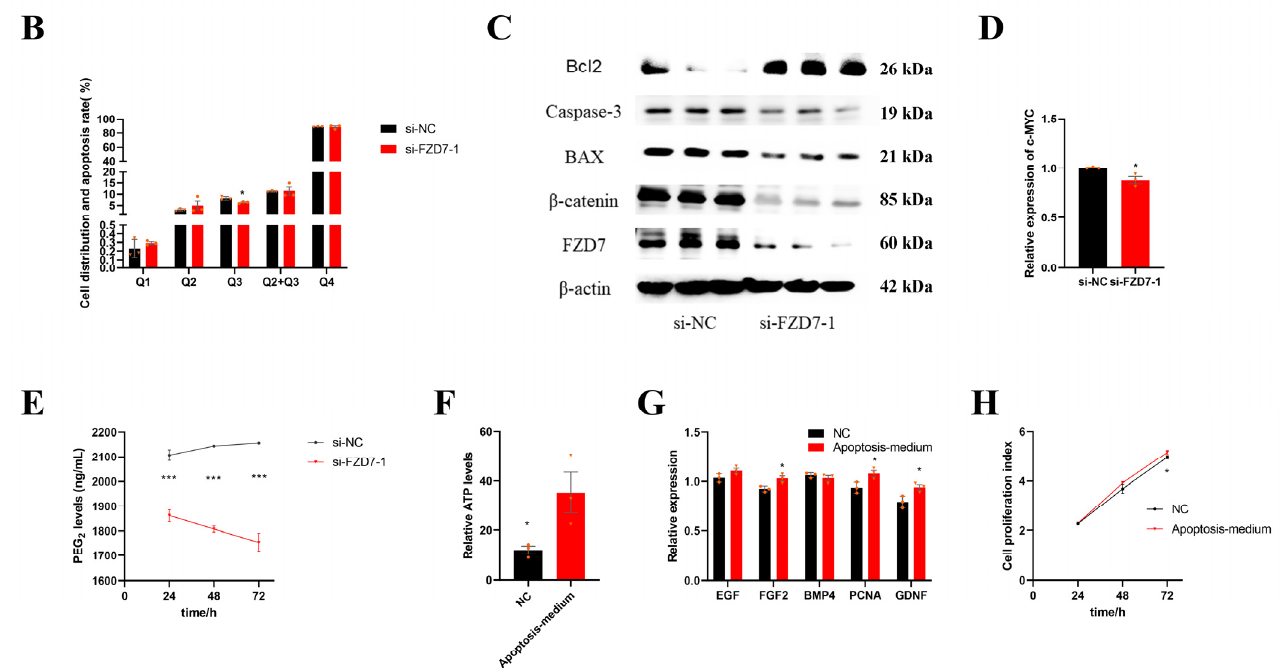
Figure 6. Sertoli cells’ repopulation by the early apoptosis. ( A , B ) Cell apoptosis phase distributions were detected using Annexin V-FITC/PI staining assay. Q1—the percentage of necrotic cells; Q2—the percentage of late apoptotic cells; Q3—the percentage of early apoptotic cells; Q4— non-apoptotic cells. ( C ) Protein expression of cell apoptosis marker genes, and those proteins were determined using western blot analysis. The β -actin gene was used as the internal control. ( D ) Relative mRNA expression levels of c-MYC . ( E ) The PGE2 level was measured using a porcine PGE2 ELISA kit. ( F ) The relative ATP level for apoptosis-medium treatment. ( G ) Relative mRNA expression of the key genes of cell proliferation for apoptosis-medium treatment. ( H ) Cell proliferation index for apoptosis-medium treatment. Orange triangles and circles represented the numerical distribution of three biological repeats in each group. Data are presented as the mean ± SEM. * p < 0.05. and *** p <